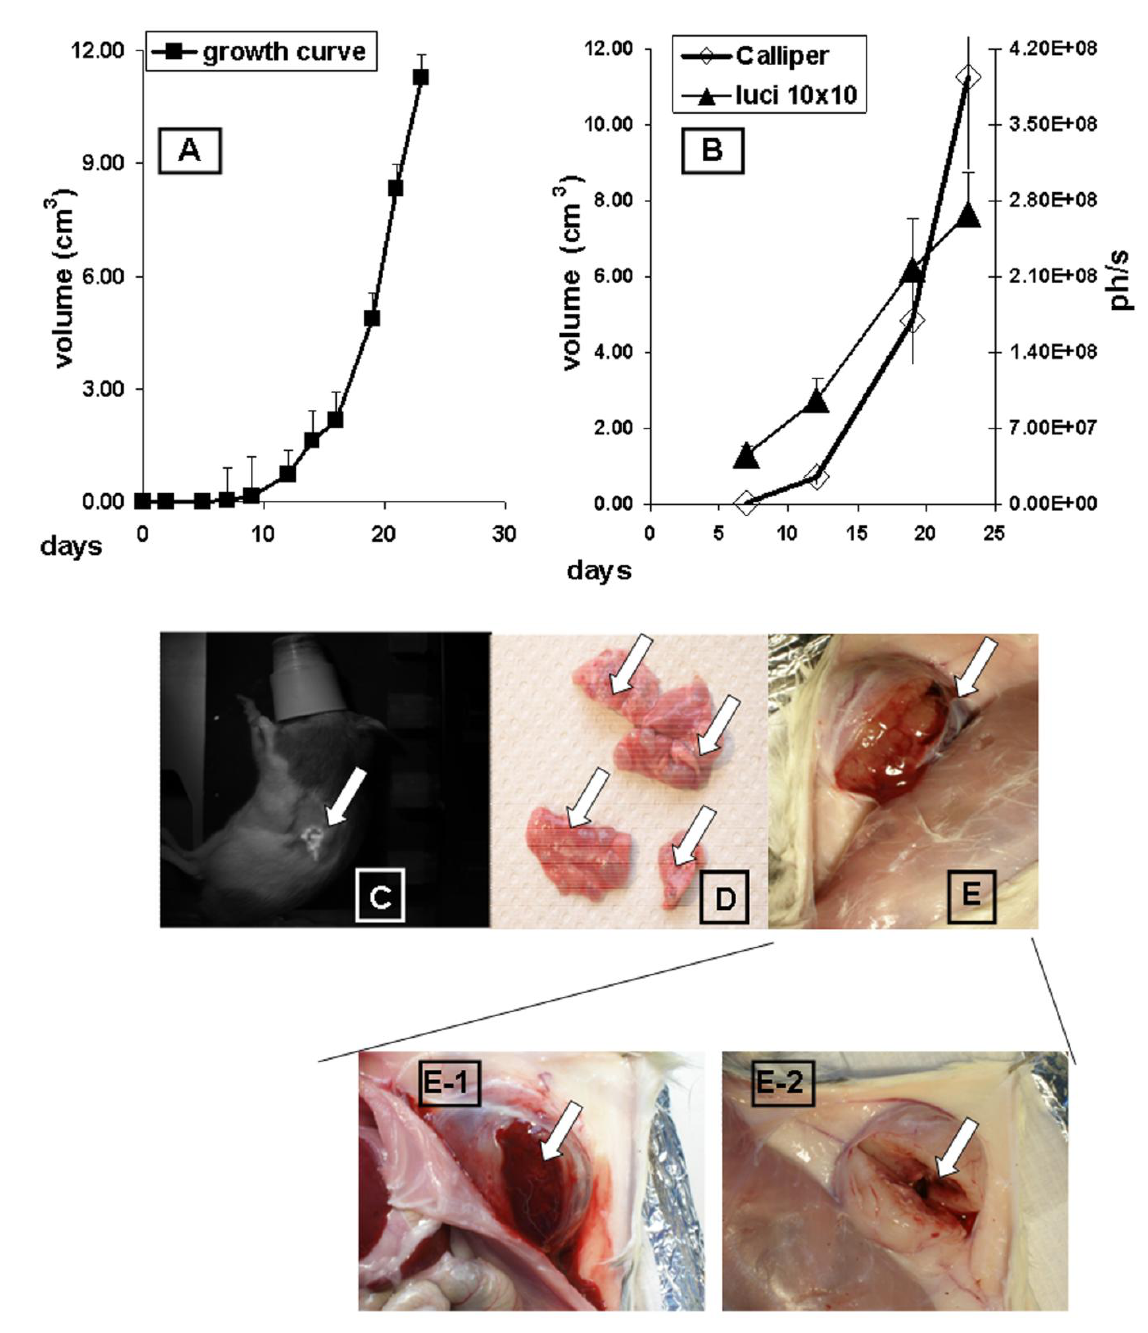
Figure 1. Growth characteristics of subcutaneous MAT-Lu PCa. Tumor growth was followed up every other day by callipering ( A ) and terminated at day 24. In vivo bioluminescence image-analysis ( B : ▲) once a week in a Nightowl LB981 camera system (Berthold, Bad-Wildbach, Germany) shows a significant correlation to the tumor volume determined by callipering ( B : ◊). Overlays of in vivo images and rat photographs ( C ). Infiltrated lungs with clearly visible metastases ( D ). Cystic structure of the subcutaneous MAT-Lu tumors ( E ), characterized by mucous necrotic liquid (E 1) and a rather loose inner structure